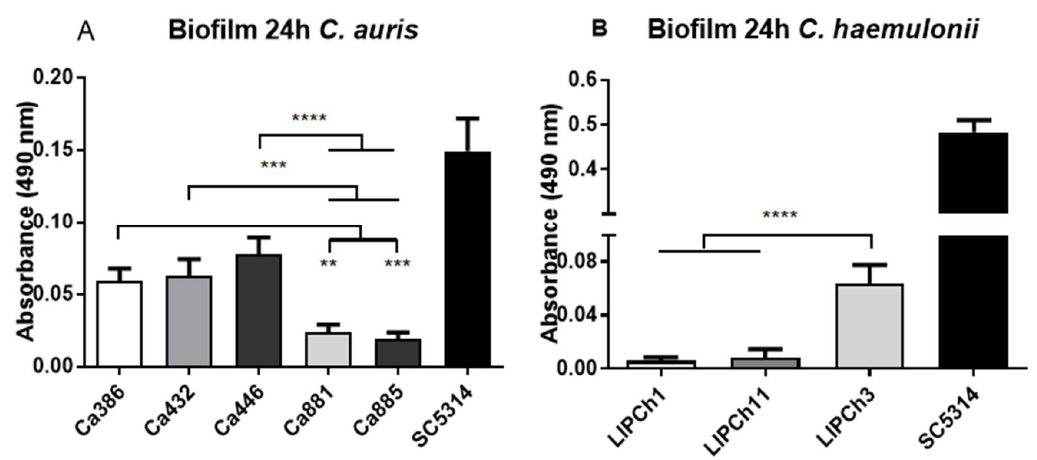
Figure 6. C. auris ( A ) and C. haemulonii ( B ) isolates were incubated in RPMI medium and after 24 h, the biofilm formation was revelated by XTT / menadione addition. The colorimetric reaction was read spectrophotometrically (490 nm). Statistic di ff erences were observed between the isolates of high and low virulence in both experiments. C. albicans SC5314 was used as positive control. ** p < 0.05, *** p < 0.001, **** p < 0.0001. Error bars represent standard deviations between samples (biologic replicates) from the same